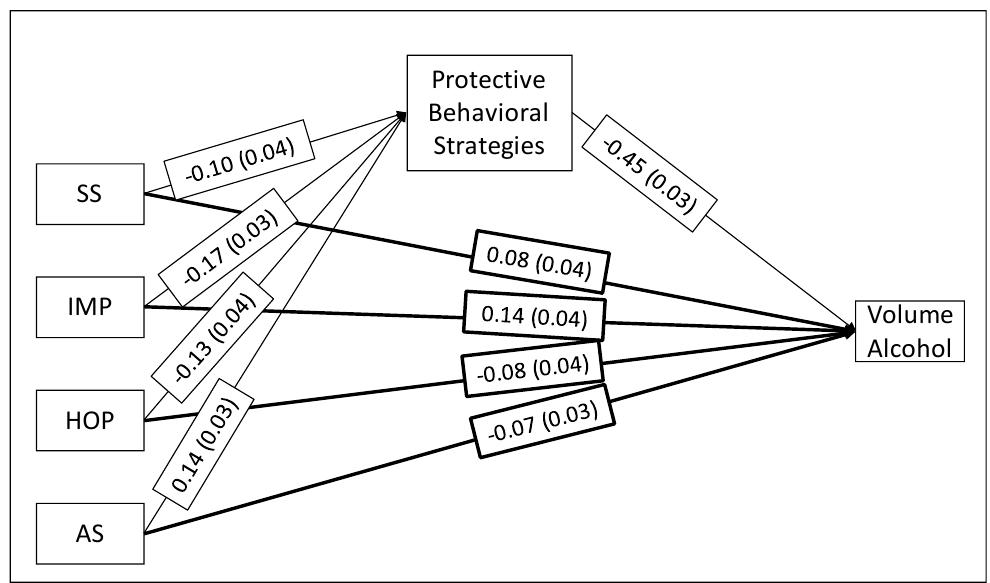
Figure 1. Standardized coefficients for the Study 1 mediational model (a, b, and c’ paths) from Substance Use Risk Profile Scale (SURPS) [4] personality traits to the volume of alcohol used through protective behavioral strategy (PBS) use. SS = SURPS Sensation Seeking; IMP = SURPS Impulsivity; HOP = SURPS Hopelessness; AS = SURPS Anxiety Sensitivity. Light lines represent indirect effects through PBS use, and heavy lines represent direct effects. All paths were significant, p < 0.01.